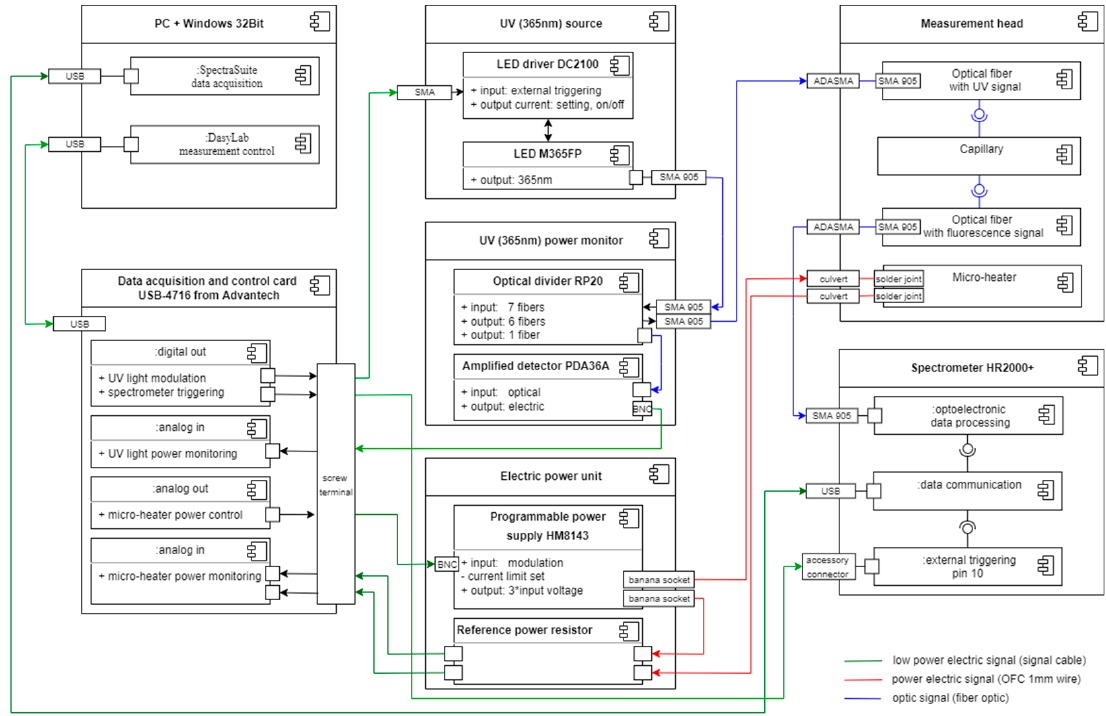
Figure 6. The component diagram of the measurement setup.